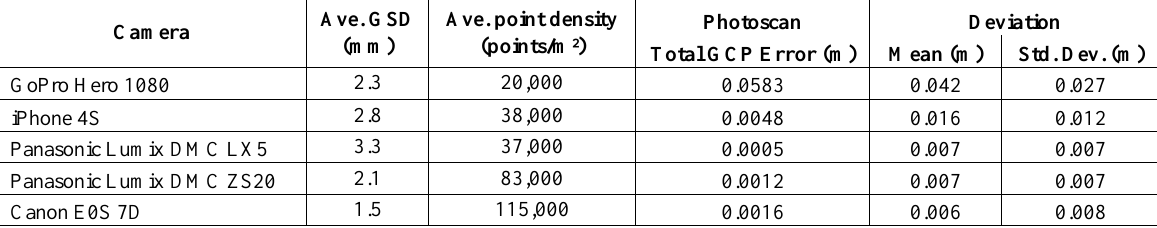
Photoscan and mean and standard deviation of deviation analysis from